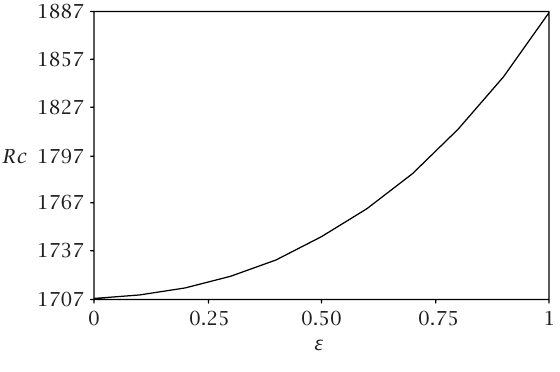
Figure 4.4 . Variation of Rc with ε : P = 0 . 1, ω = 50 . 0, and a = 3 .